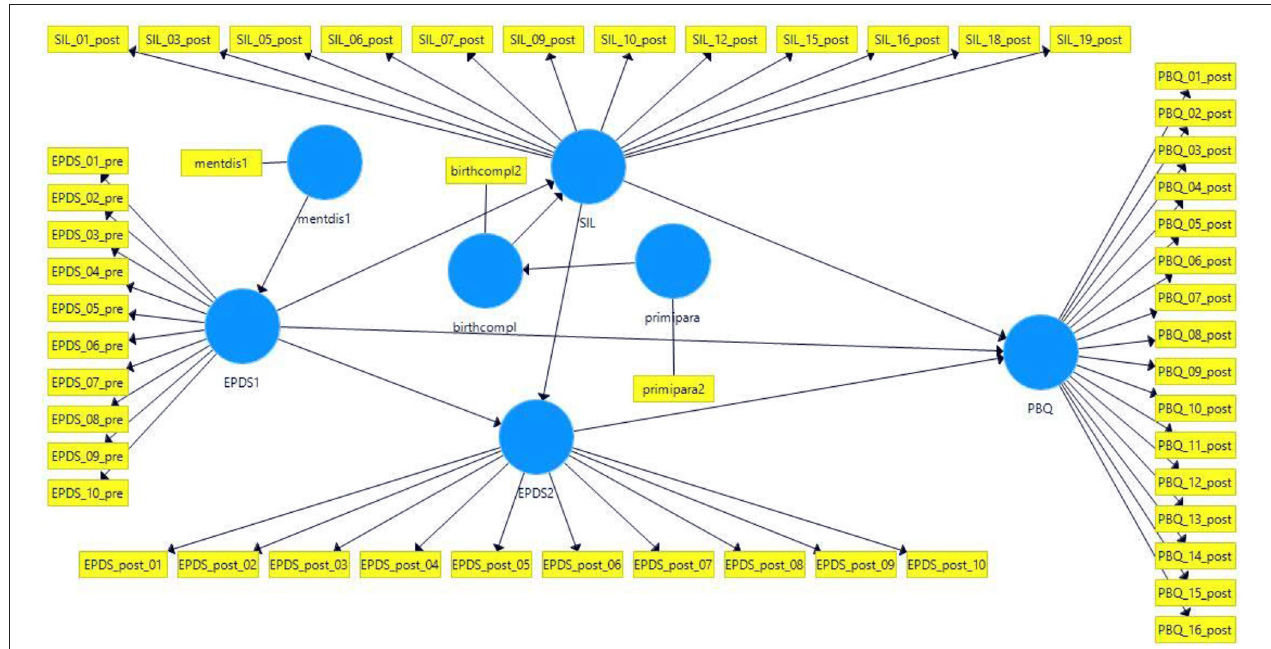
FIGURE 1 | Partial Least Squares Structural Equation Model (PLS-SEM) predicting maternal bonding. mentdis1, Factor variable indicating self-reported prior mental health problems (prepartum); EPDS1, Prepartum depression score; birthcompl, Factor variable indicating birth complication at last labor (postpartum); SIL, Short version of Salmon’s Item List to assess birth experience (postpartum); Primipara, Factor variable indicating primiparous women (prepartum); EPDS2, Postpartum depression score; PBQ, Postpartum impairment in mother-infant